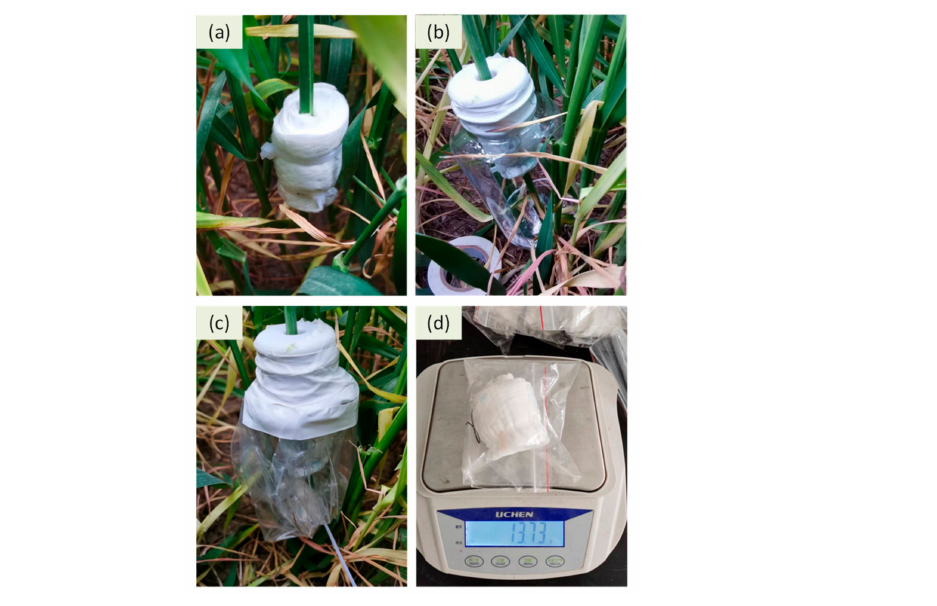
Figure 2. Pictures of the stemflow water measurement in the field, ( a ) wrapping a high-water- adsorption sheet (HWAS) around the wheat stems, ( b ) placing plastic sheets to cover the HWAS to prevent irrigation water from falling into the inside materials, ( c ) sealing the upside opening, and ( d ) measuring the HWAS mass to calculate the stemflow